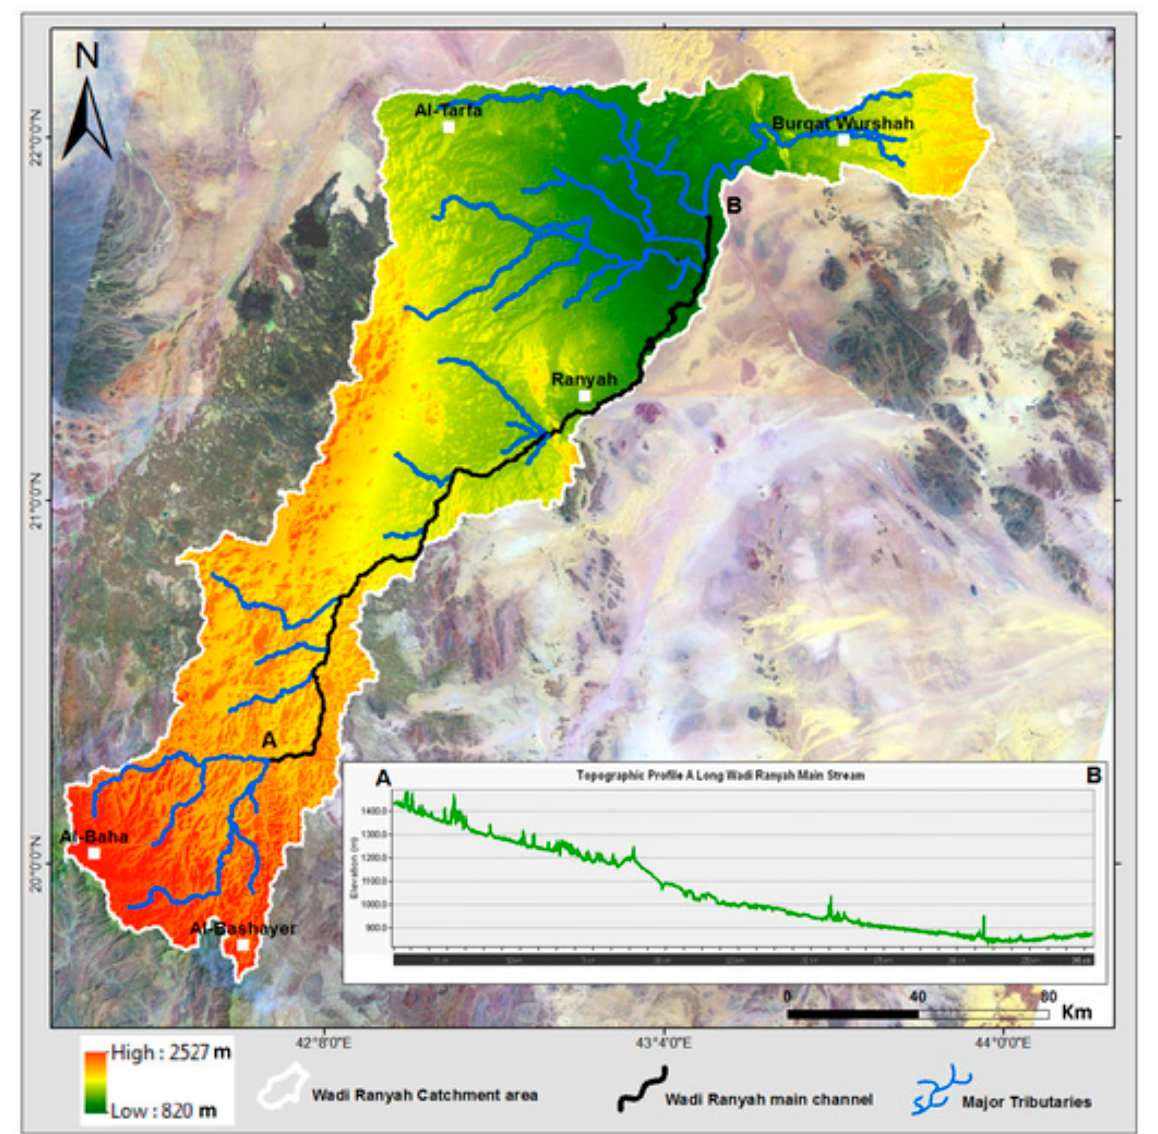
Figure 3. Topographic map with a topographic profile (AB) of the studied area.